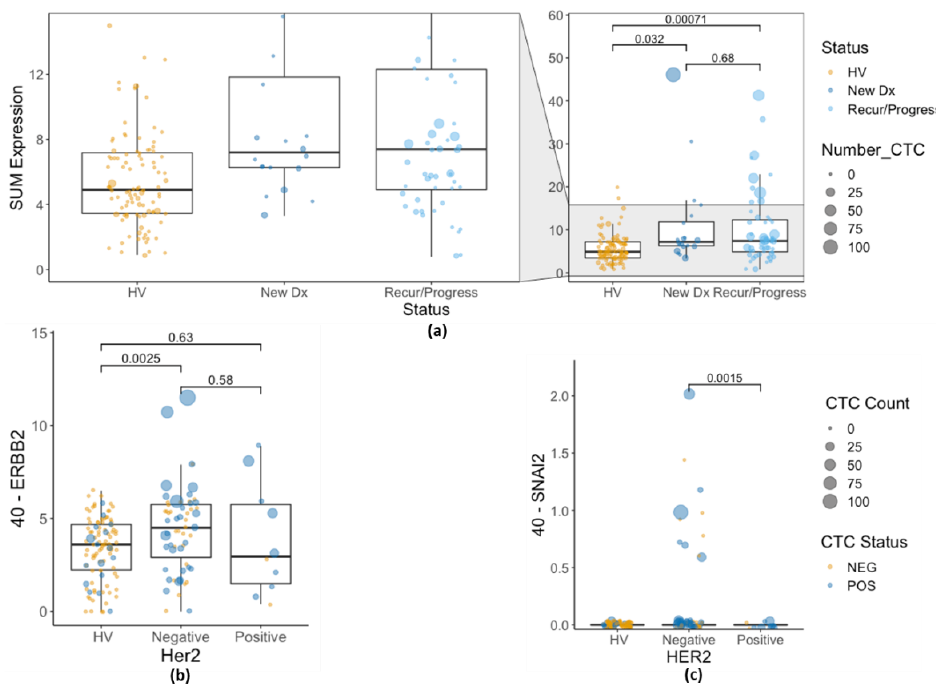
Figure 4. ( a ) Sum of CTC-related gene expression (40-Sum of EPCAM, KRT19, ERBB2, SNAI2, and TWIST Ct values) in HV, newly diagnosed MBC, and MBC with recurrence or progression. ( b ) ERBB2 expression in CTC-enriched samples by tissue HER2 status. ( c ) SNAI2 expression in CTC-enriched samples by tissue HER2 status. CTC, circulating tumor cell; HV, healthy volunteer; MBC, metastatic breast cancer.